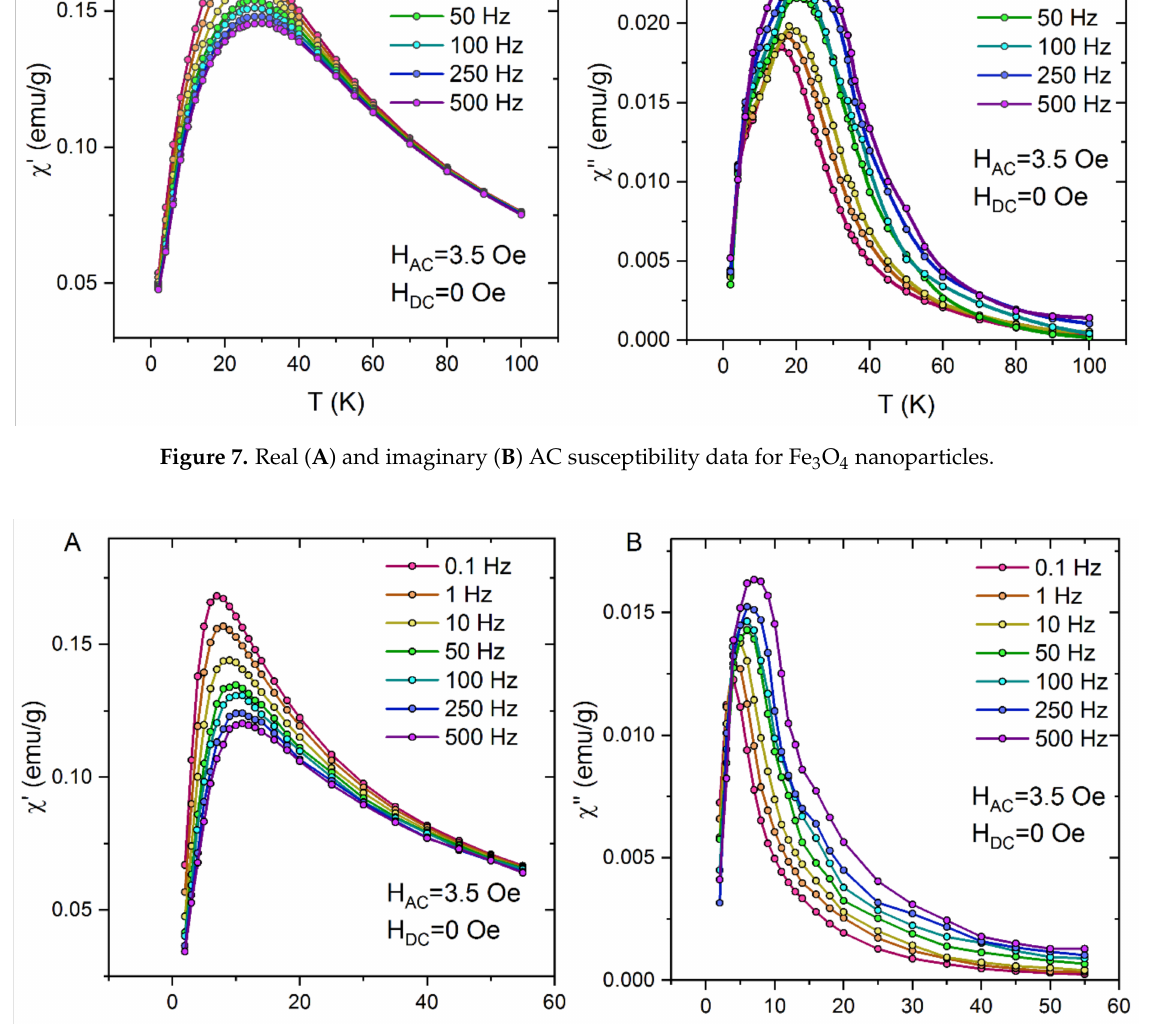
Fe 3 O 4 NPs and τ 0 = 6.42 × 10 − 8 s, E a / k B = 72.6 K for PCL fibres with magnetite